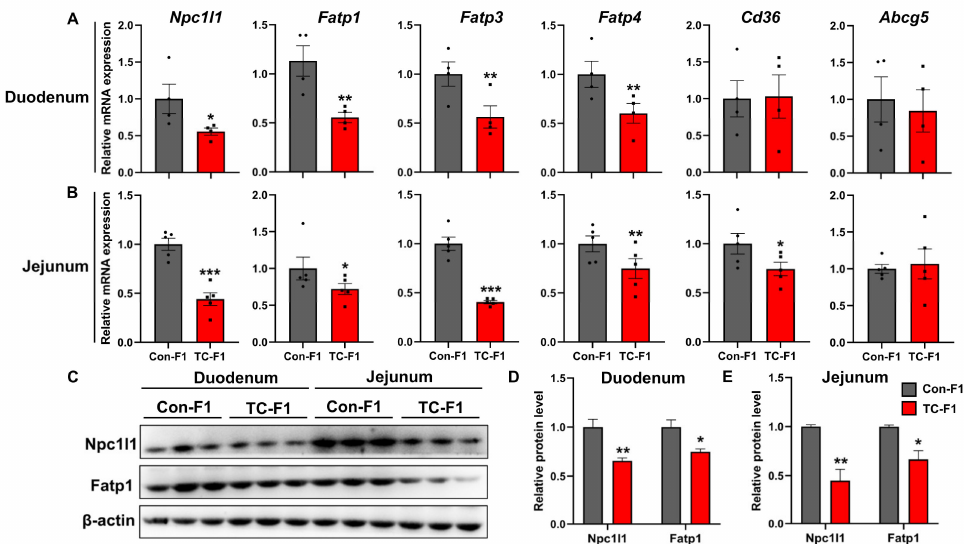
Figure 5. TC exposure in early life impairs the expression of intestinal lipid-related transporter genes in female offspring. ( A , B ) mRNA expression of Npc1l1 , Fatp1 , Fatp3 , Fatp4 , Cd36 and Abcg5 in the duodenum ( A ) and jejunum ( B ) of 8-week-old offspring female mice, n = 4–5. ( C ) Npc1l1 and Fatp1 protein levels in duodenum and jejunum of 8-week-old offspring female mice. ( D , E ) Quantitative statistics of Npc1l1 and Fatp1 protein levels in duodenum ( D ) and jejunum ( E ). n = 3. Data are presented as mean ± SEM. * p < 0.05, ** p < 0.01, *** p < 0.001 vs.